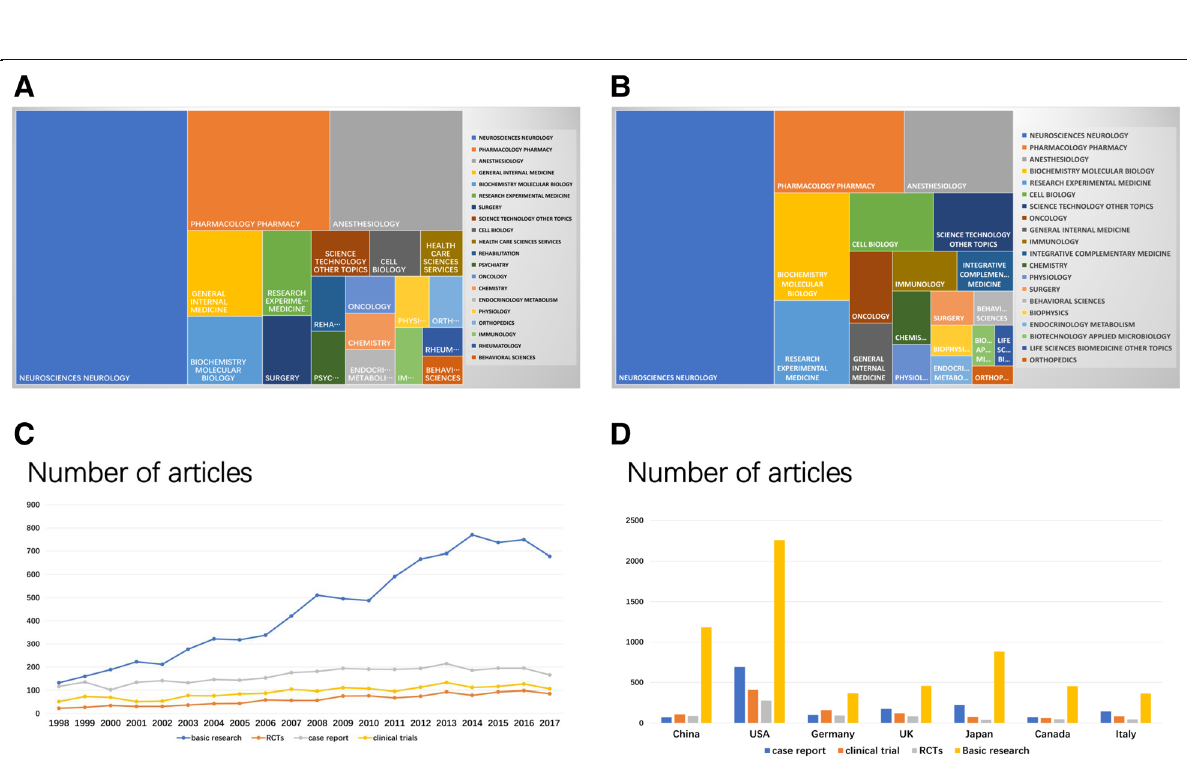
Fig. 3 The difference of research categories and article types in world and China ( a ) The research categories on neuropathic pain in world. ( b ) The research categories on neuropathic pain in China. ( c ) The article types analysis regarding neuropathic pain in the past two decades worldwide. ( d